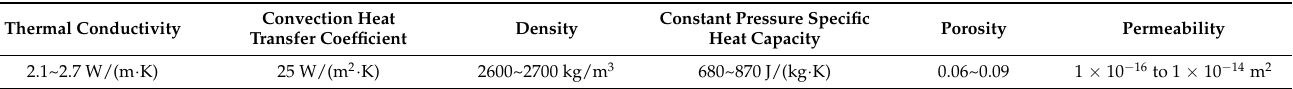
Table 3. Gradient range of parameter settings in the surrounding rock section of the model.